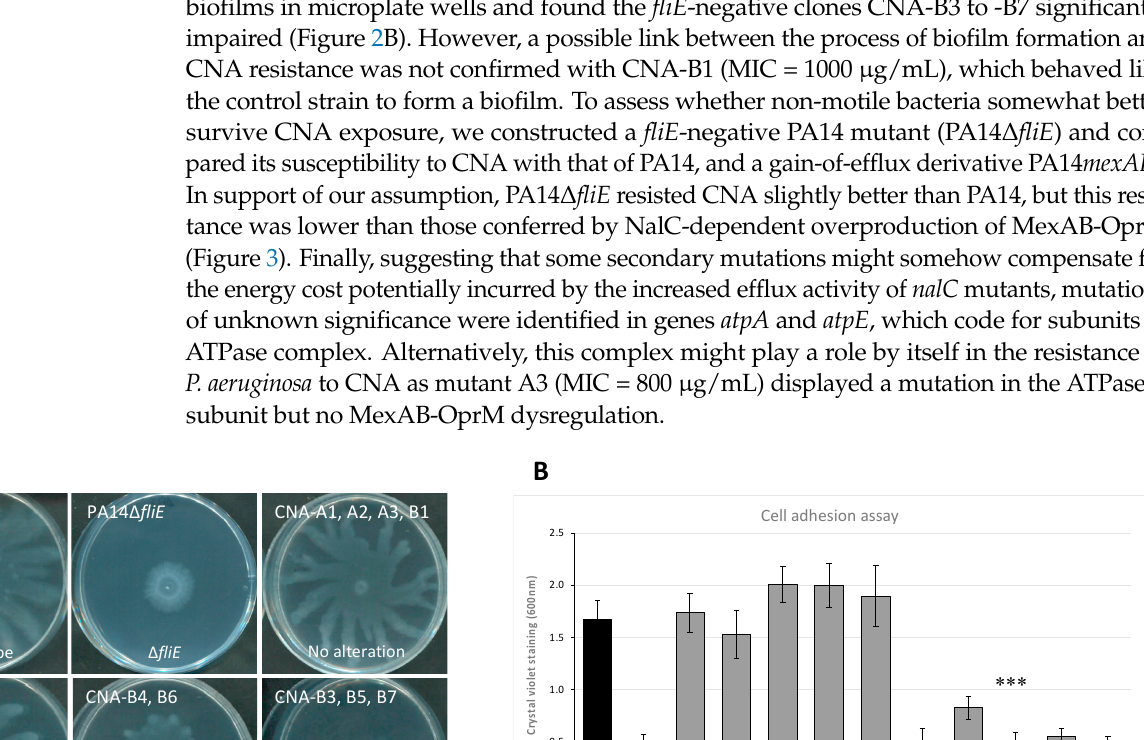
Figure 2. Motility and initial surface attachment of CNA-resistant mutants. ( A ) Swarming motility: Figure 3. Increased resistance of PA14 ∆ fliE to CNA. Serial Log 10 dilutions of strain PA14 and its 242 the mutations found in genes responsible for flagellar structure/assembly, pili formation, and biosyn- derivative mutants PA14 ∆ fliE and PA14 ∆ nalC all calibrated at 0.5 McFarland were spotted onto the 243 thesis of biofilm matrix are indicated. ( B ) Absorbance at 600 nm is representative of sessile bacteria stained by crystal-violet in microplates (mean values resulting from 10 replicates; Student’s t-test, surface of a MHA plate containing 600 µg/mL CNA. *** p -value < 0.001).